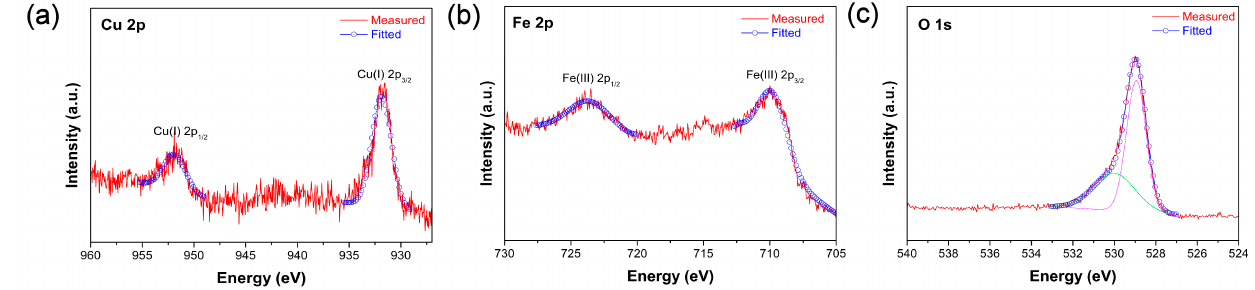
Figure 6. XPS spectra of electrodeposited CuFeO 2 film in DMSO based electrolyte containing 1 mM Cu(NO 3 ) 2 ∙ xH 2 O/3 mM Fe(ClO 4 ) 3 ∙ xH 2 O/100 mM potassium perchlorate with an applied current density of − 0.1 mA cm − 2 for 30 min after post-annealing treatment at 650 °C for 1hr under N 2 gas flow: ( a ) Cu 2p, ( b ) Fe 2p, and ( c ) O 1s.